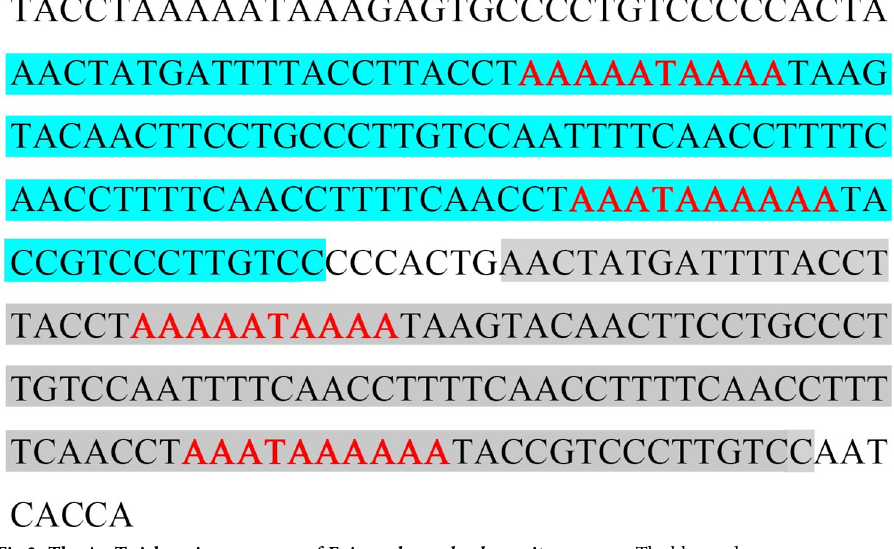
Fig 3. The A +T rich region sequence of Episymploce splendens mito-genome. The blue and gray areas represented two 120bp-long repeated segments, respectively. The red fonts represented the poly-A